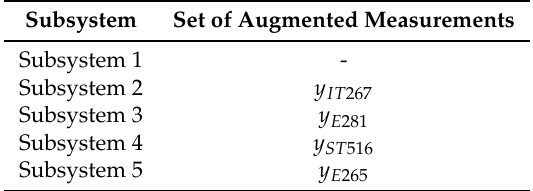
Table 3. Set of augmented measurements for each ADAPT subsystem using the global method.